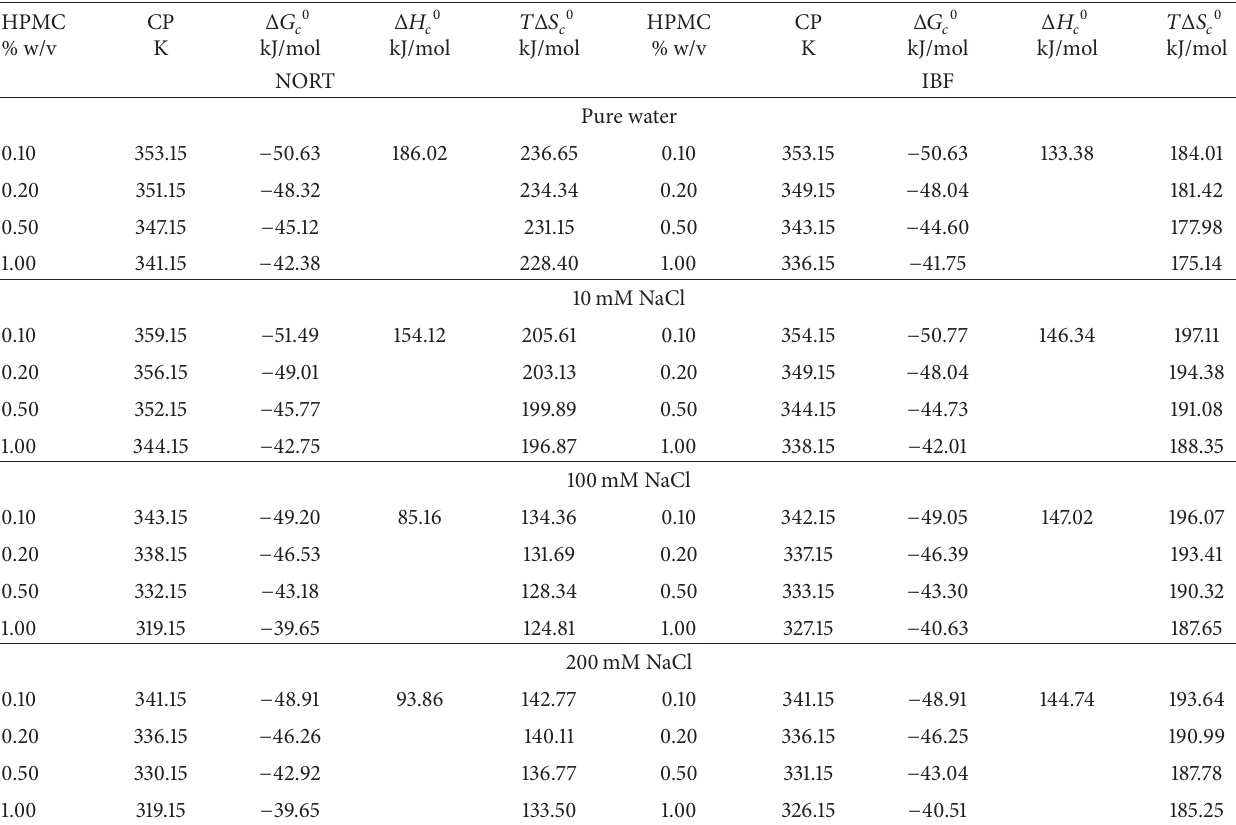
Table 1: Cloud point (CP) and energetic parameters for clouding in different weight percent of HPMC solutions in the presence of NORT (50 mM) and IBF (50 mM) in presence and absence of various salts. The uncertainties in the CP values lie within ± 0.1